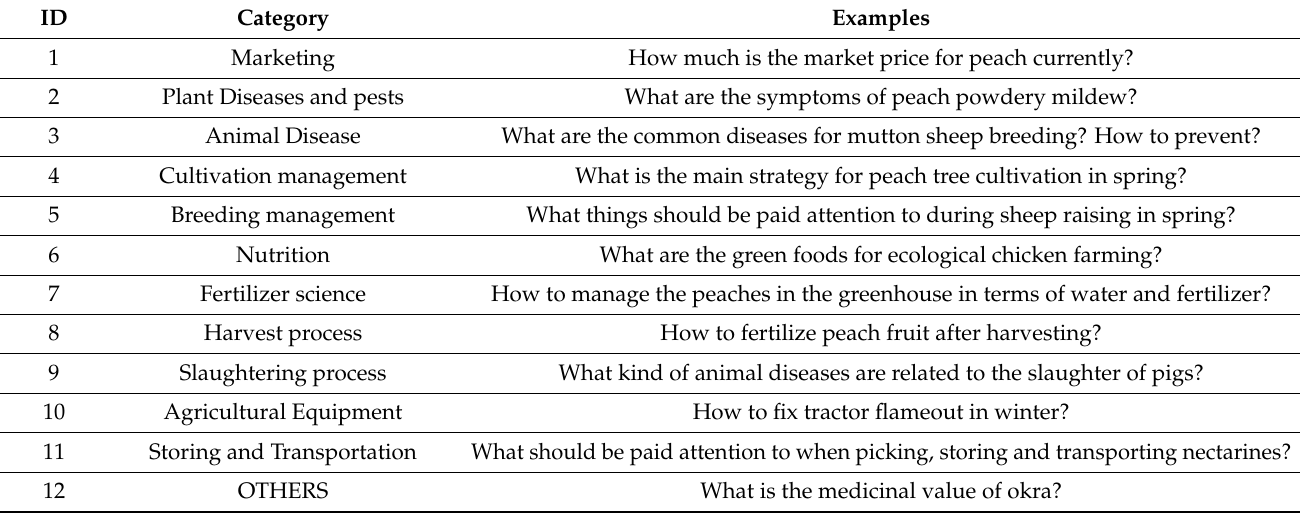
Table 3. Sample questions for 12 categories.